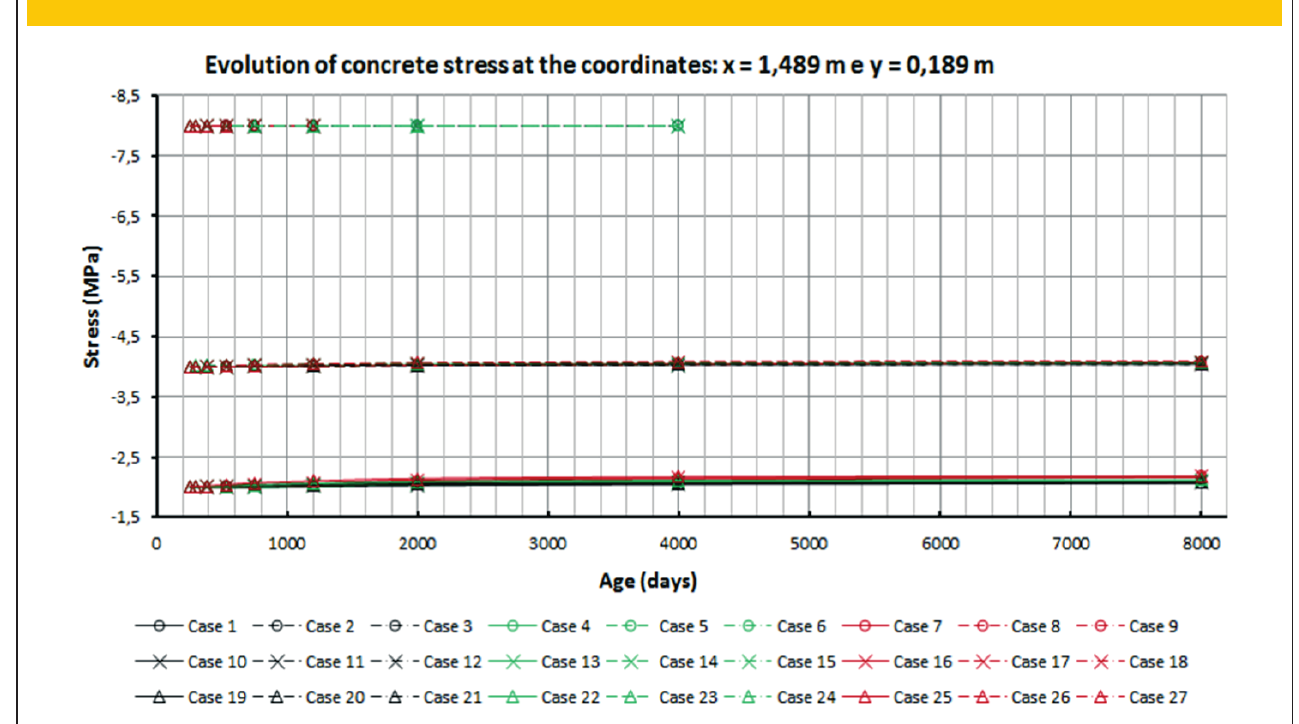
Figure 11 – Stresses on the concrete solid mass on the “x” direction during the AAR swelling